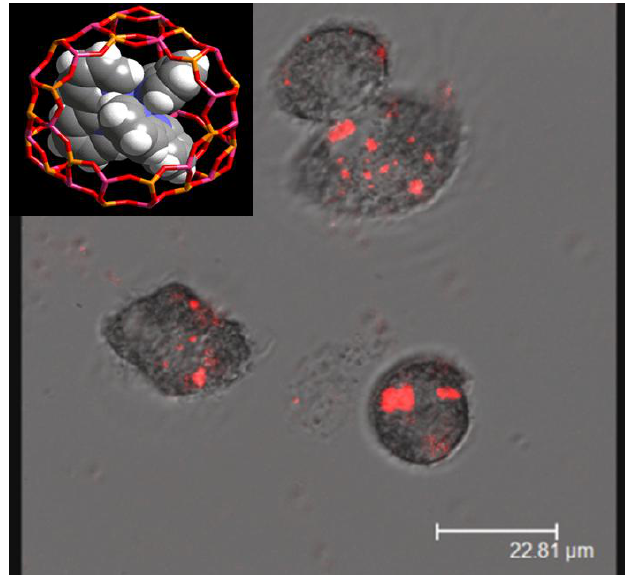
Figure 13. Fluorescence images of macrophage cells with tris-bipyridine ruthenium dye loaded zeolite Y (inset) (adapted from Reference